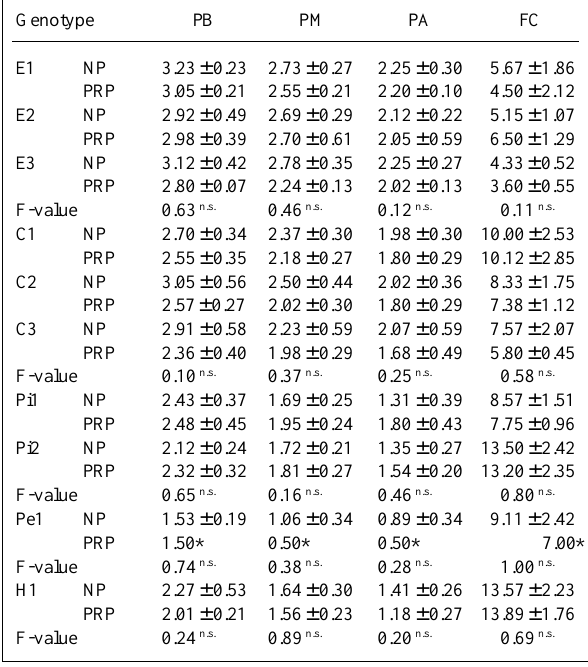
List of genotypes by species: L. esculentum : E1: cv. Nor, E2: cv. Platense Italiano, E3: cv. Caimanta; L. esculentum var. cerasiforme : C1: LA 1385, C2: LA 1673, C3: Z 1994; L. pimpinellifolium : Pi1: LA 722, Pi2: Z 1995; L. peruvianum : Pe1: LA 2151; L. hirsutum : H1: LA 2128. PB: Stem perimeter at the base (cm); PM: stem perimeter in the middle (cm); PA: stem perim- eter at the top (cm); FC: mean number of flowers per cluster. *Data corre- sponding to only one plant. n.s. Nonsignificant.